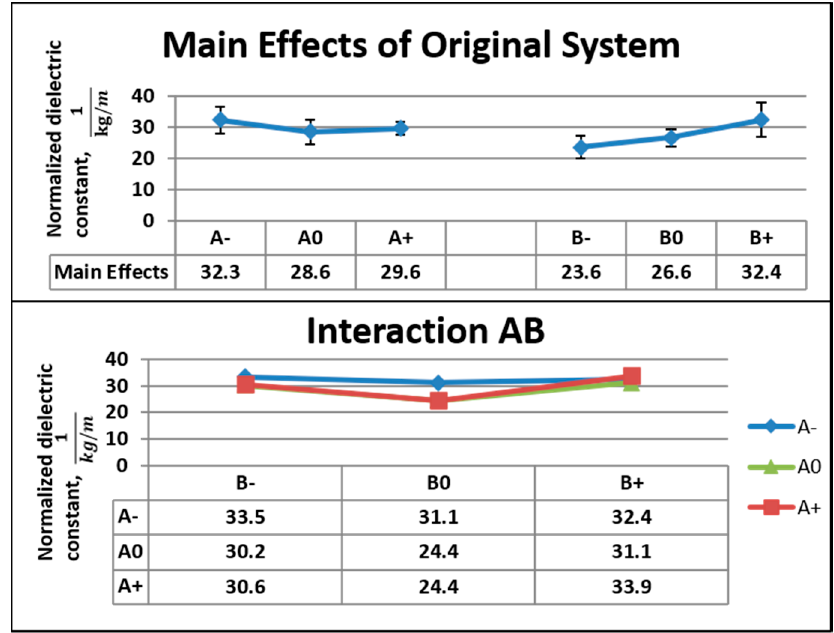
Figure 10. Main effects, standard deviation, and interactions for the dielectric data of the original system.